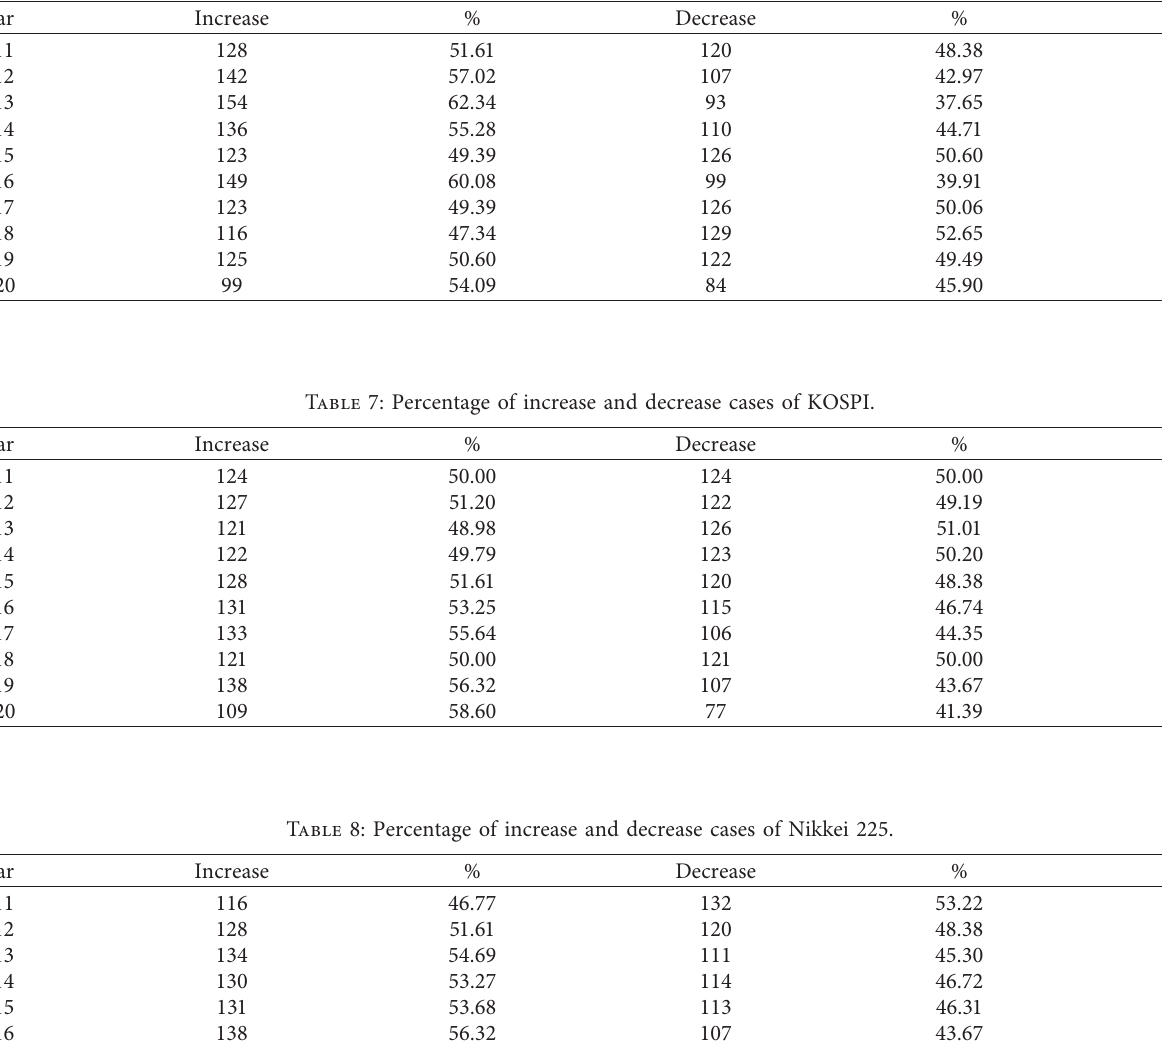
Table 6: Percentage of increase and decrease cases of KSE-100.